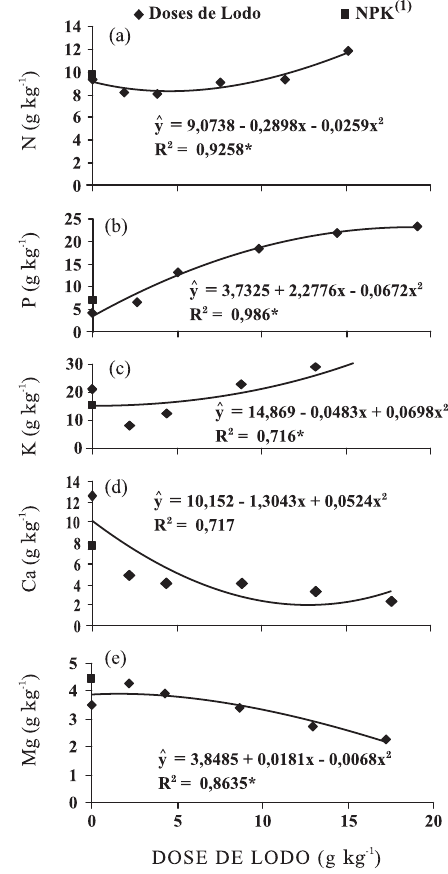
Figura 5. Variação dos teores de nitrogênio (a), fósforo (b), potássio (c), cálcio (d) e magnésio (e) nas folhas de milho após a aplicação ao solo do lodo anaeróbio da estação de tratamento de efluentes de parboilização de arroz ao solo. (1) Tratamento NPK incluído como referência fora da análise de